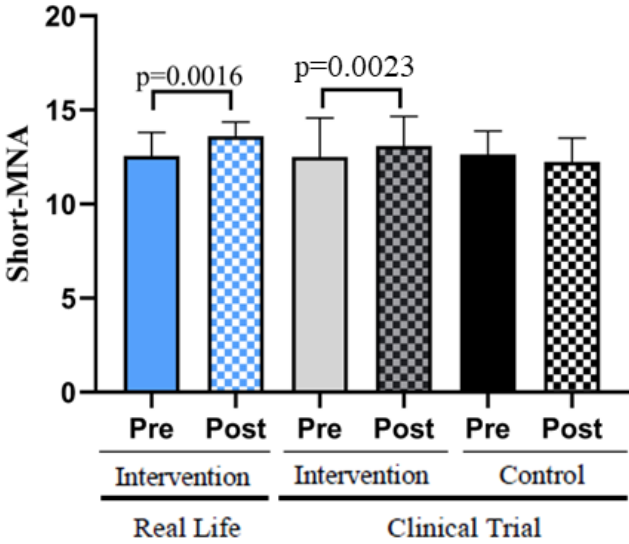
Figure 3. Nutritional status assessed with the Short-MNA Scale. Real-Life Intervention n = 50, Clinical Trial Intervention n = 51, Clinical Trial Control n = 49. Bars represent mean ± SD. Statistical analysis was performed with the Student’s t test for paired samples and the Wilcoxon test for non-parametric samples.